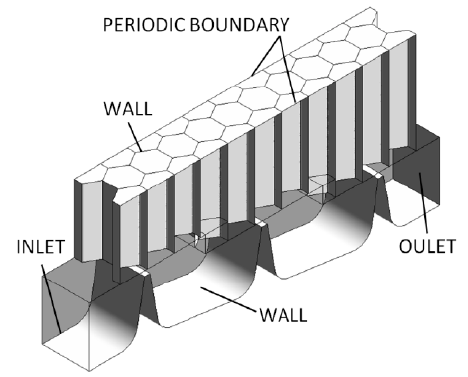
Table 3. Rhomboidal pattern design: rhombus diagonal ratio C R , half of rhombus minor angle δ ,